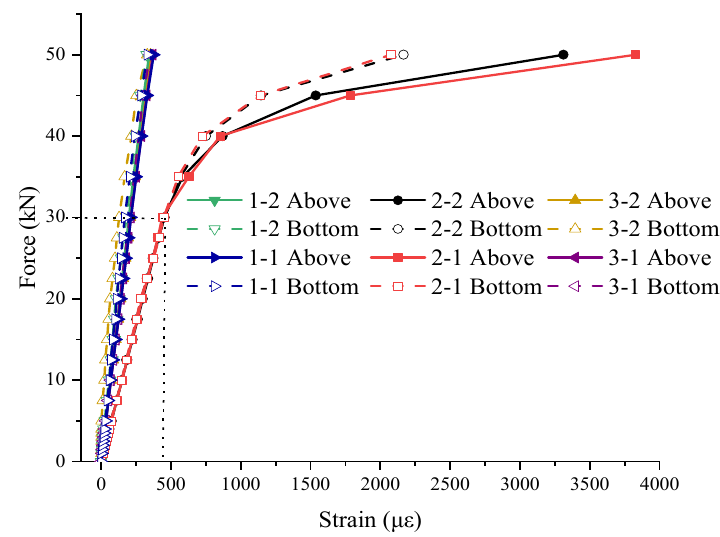
Figure 4. Deformation curve of steel-3PE.